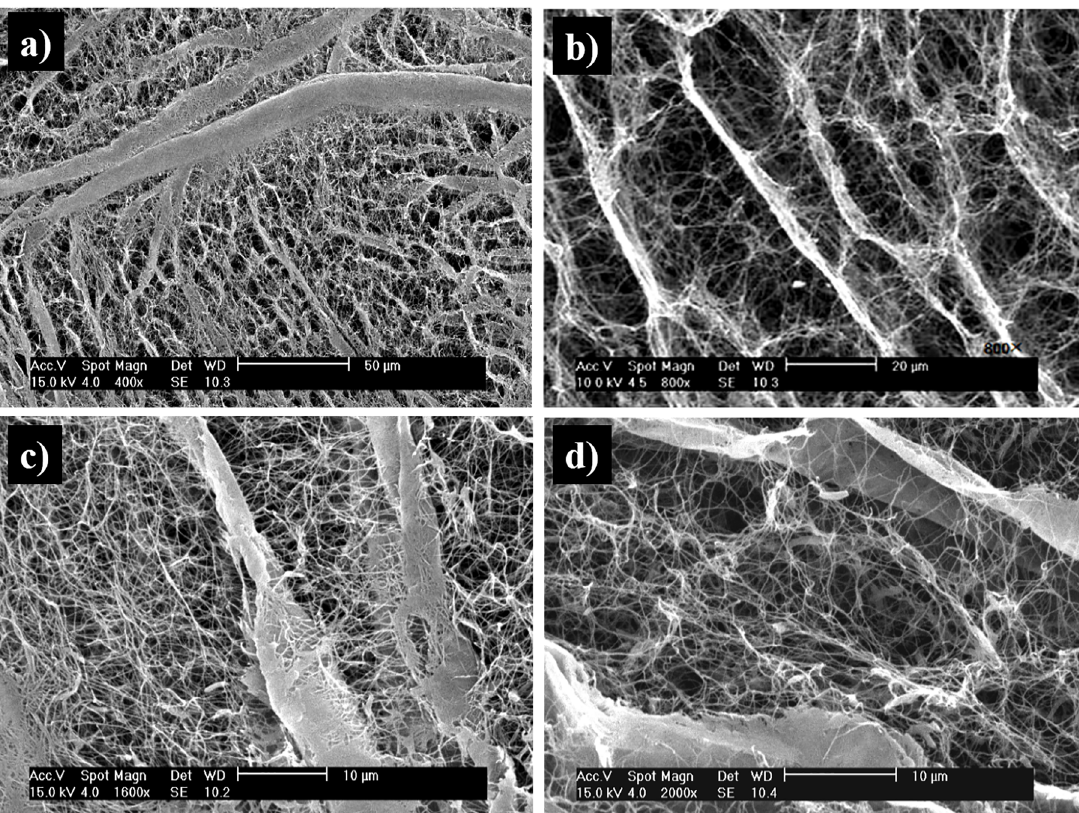
Figure 3. Scanning electron microscopic (SEM) image showing several layers of internal membranes, naturally developed during BNC synthesis under agitated culture.